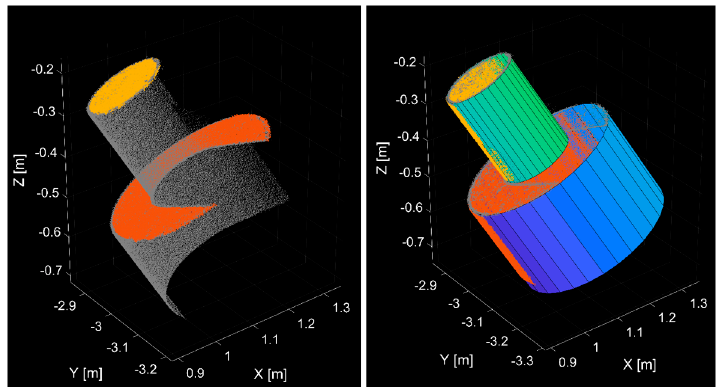
Figure 12. Result of the segmentation of the double-cylinder model.